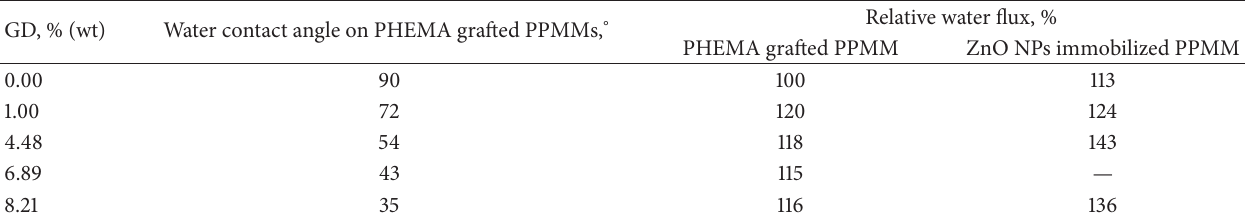
Table 1: Relative water flux (%) through PHEMA grafted and ZnO NPs immobilized PPMMs with different GD. The average water flux for the membranes is 400 ± 25 Lm − 2 h − 1 .